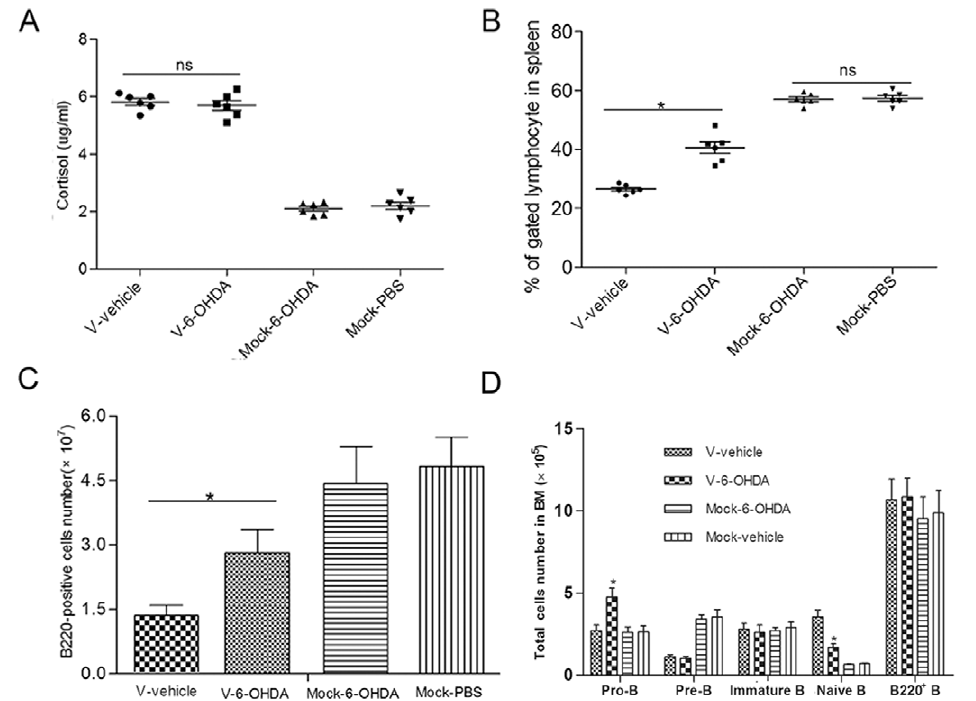
Figure 6. Role of sympathetic nervous system in the production of GCs and depletion of spleen and BM B cells. Following 6-OHDA treatment, six mice were infected i.n. with 10 4 PFU of V (V-6-OHDA) and another six mice were infected i.n. with PBS (mcok-6-OHDA). Another two groups (6 mice/group) treated with vehicle were infected i.n. with 10 4 PFU of V (V-alone) or PBS (Mock-vehicle), respectively. (A) GC levels in plasma of each group were measured using ELISA. After infected with V virus, spleen and BM cells were prepared on day 5 post-infection. The proportions (B) and numbers (C) of splenic B220 + B cells were determined. The numbers of pro-, pre-, immature B cells and mature naı¨ve B cells from BM (D) were calculated by multiplying the percentage by number of total BM cells. Data bars represent means of 6 mice from each infection group 6 SD. * p , 0.05 and ** p , 0.01 between V-vehicle and V-6-OHDA. Ns mean no statistical difference between both.